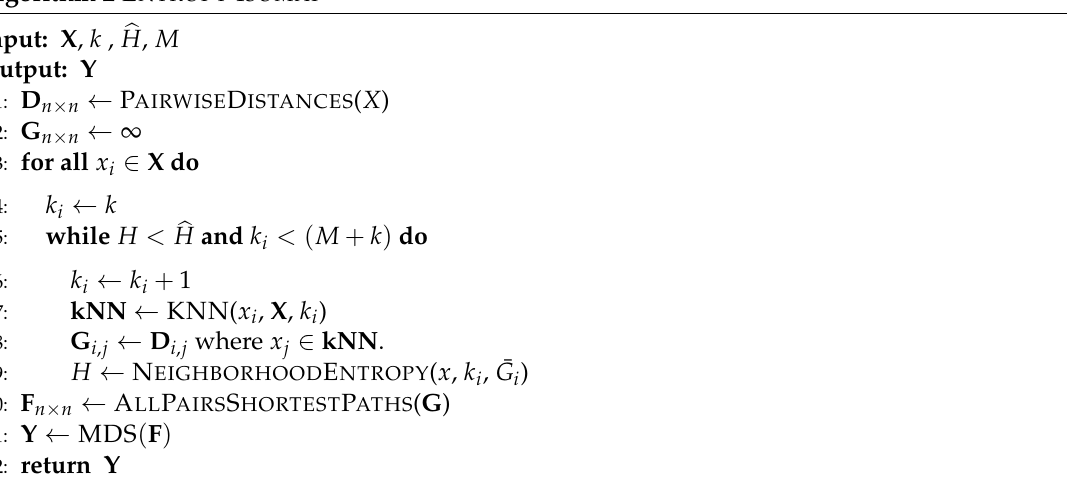
Algorithm 2 E NTROPY -I